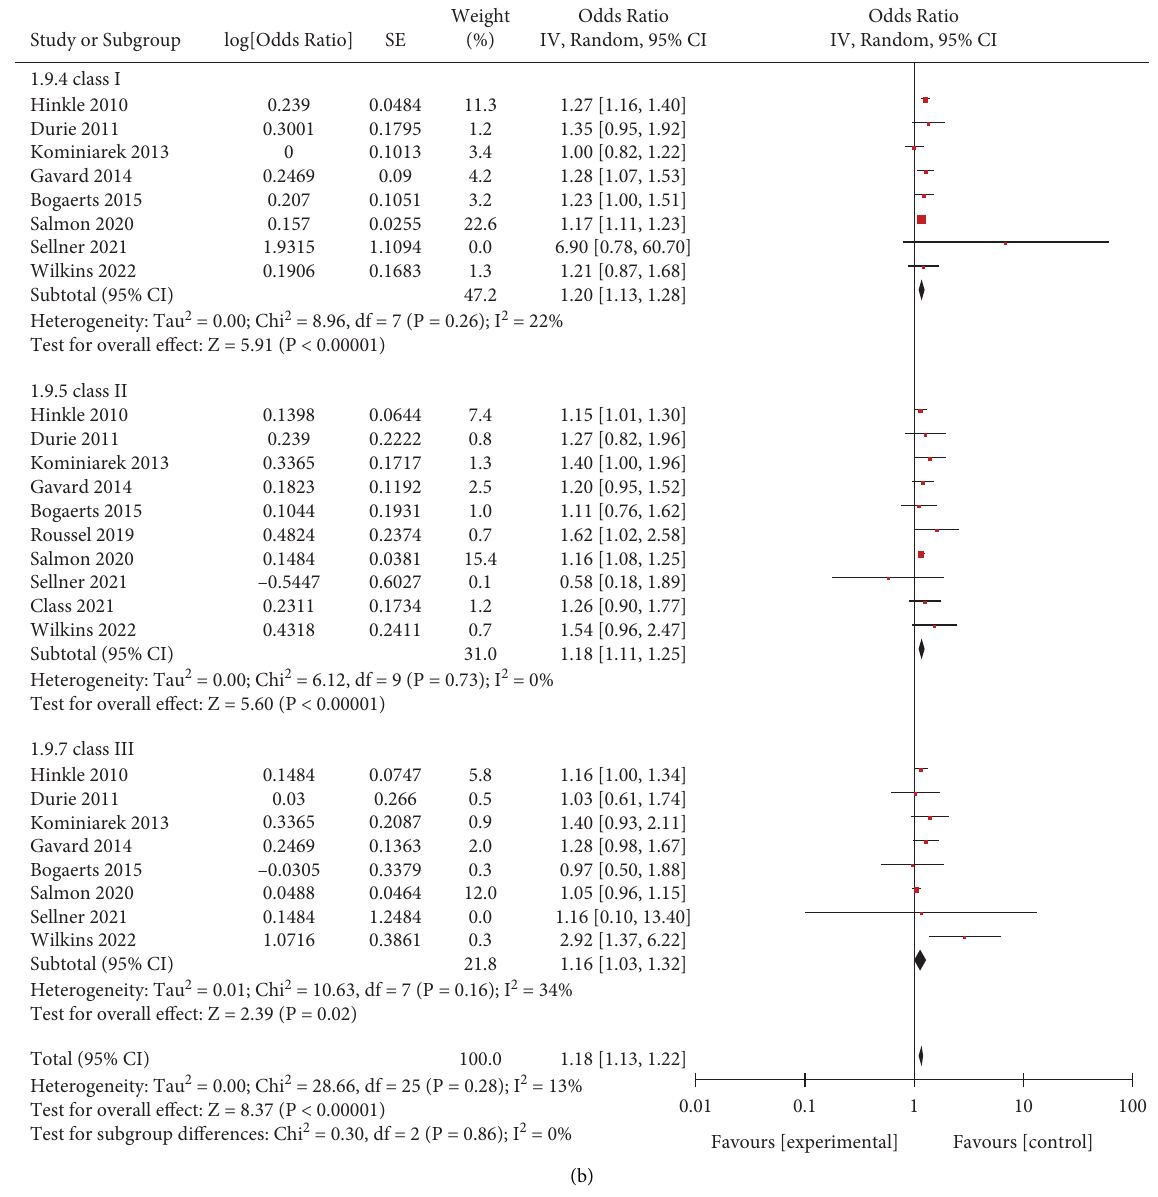
Figure 6: Forest plot of weight loss and inadequate weight with SGA for obese women of each class group. (a) Weight loss. (b) Weight